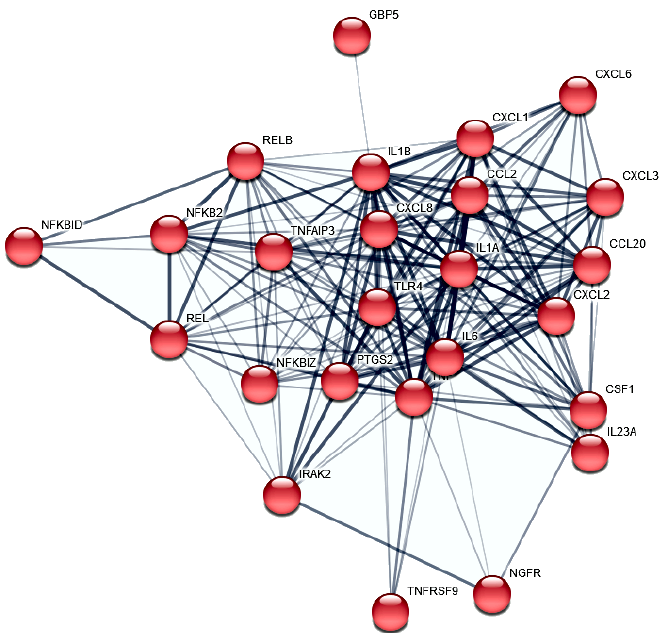
Figure 4. STRING protein–protein interactions of PC-3 PF differential expressed genes. The 23 protein to protein interactors (confidence > 0.4) annotated in cluster 1 and involved in the inflammatory response (GO:0006954) are shown.